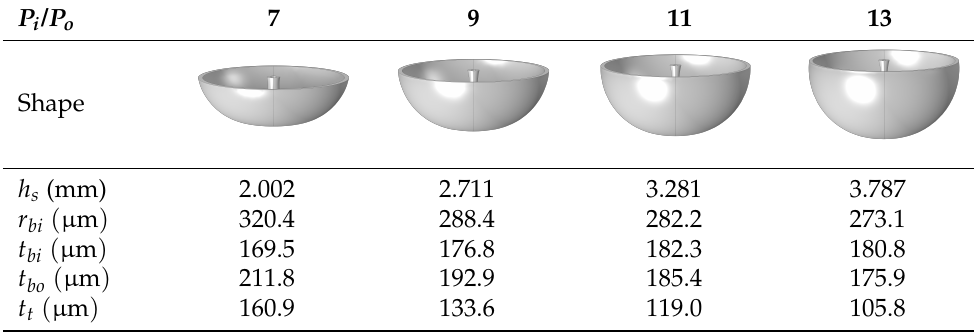
Table 3. Shape and key shape parameters of microhemispherical shells under different pressure ratios. P i / P o